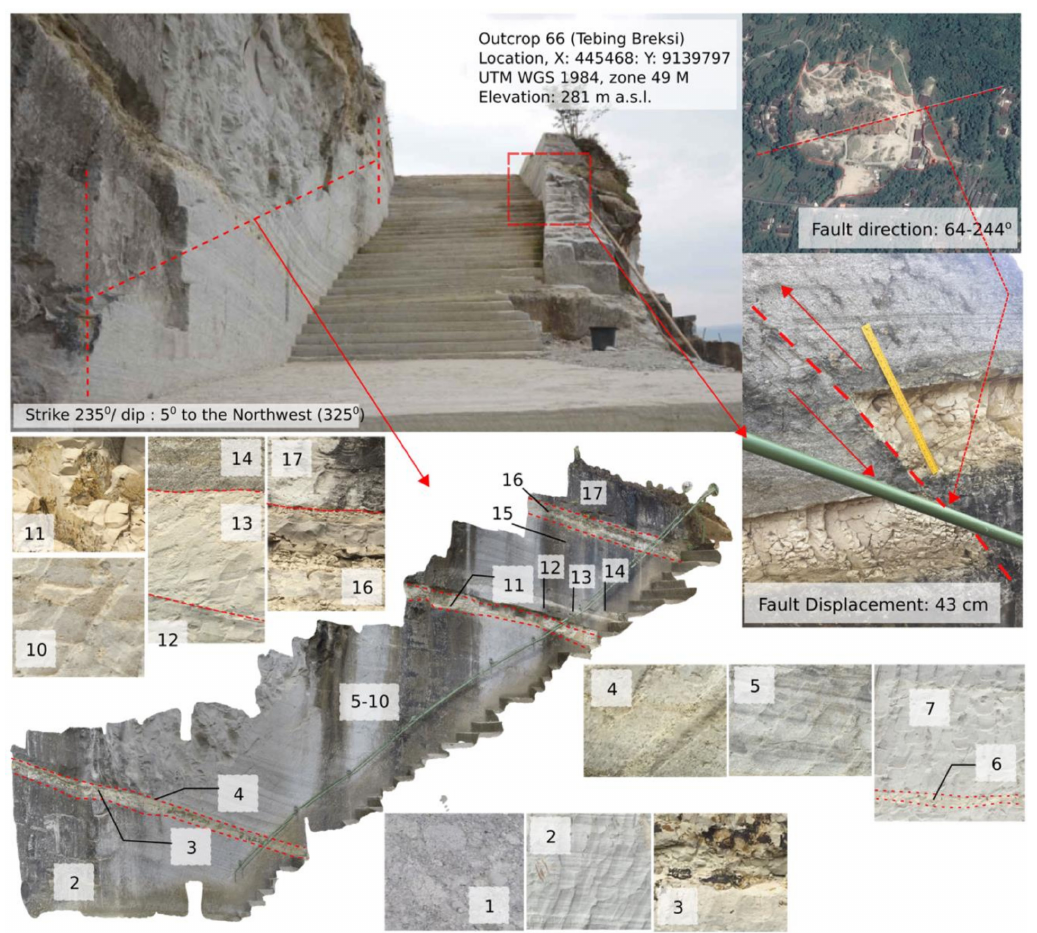
Figure 20. Fault evidence on the outcrop 66 (Tebing Breksi), Prambanan, Central